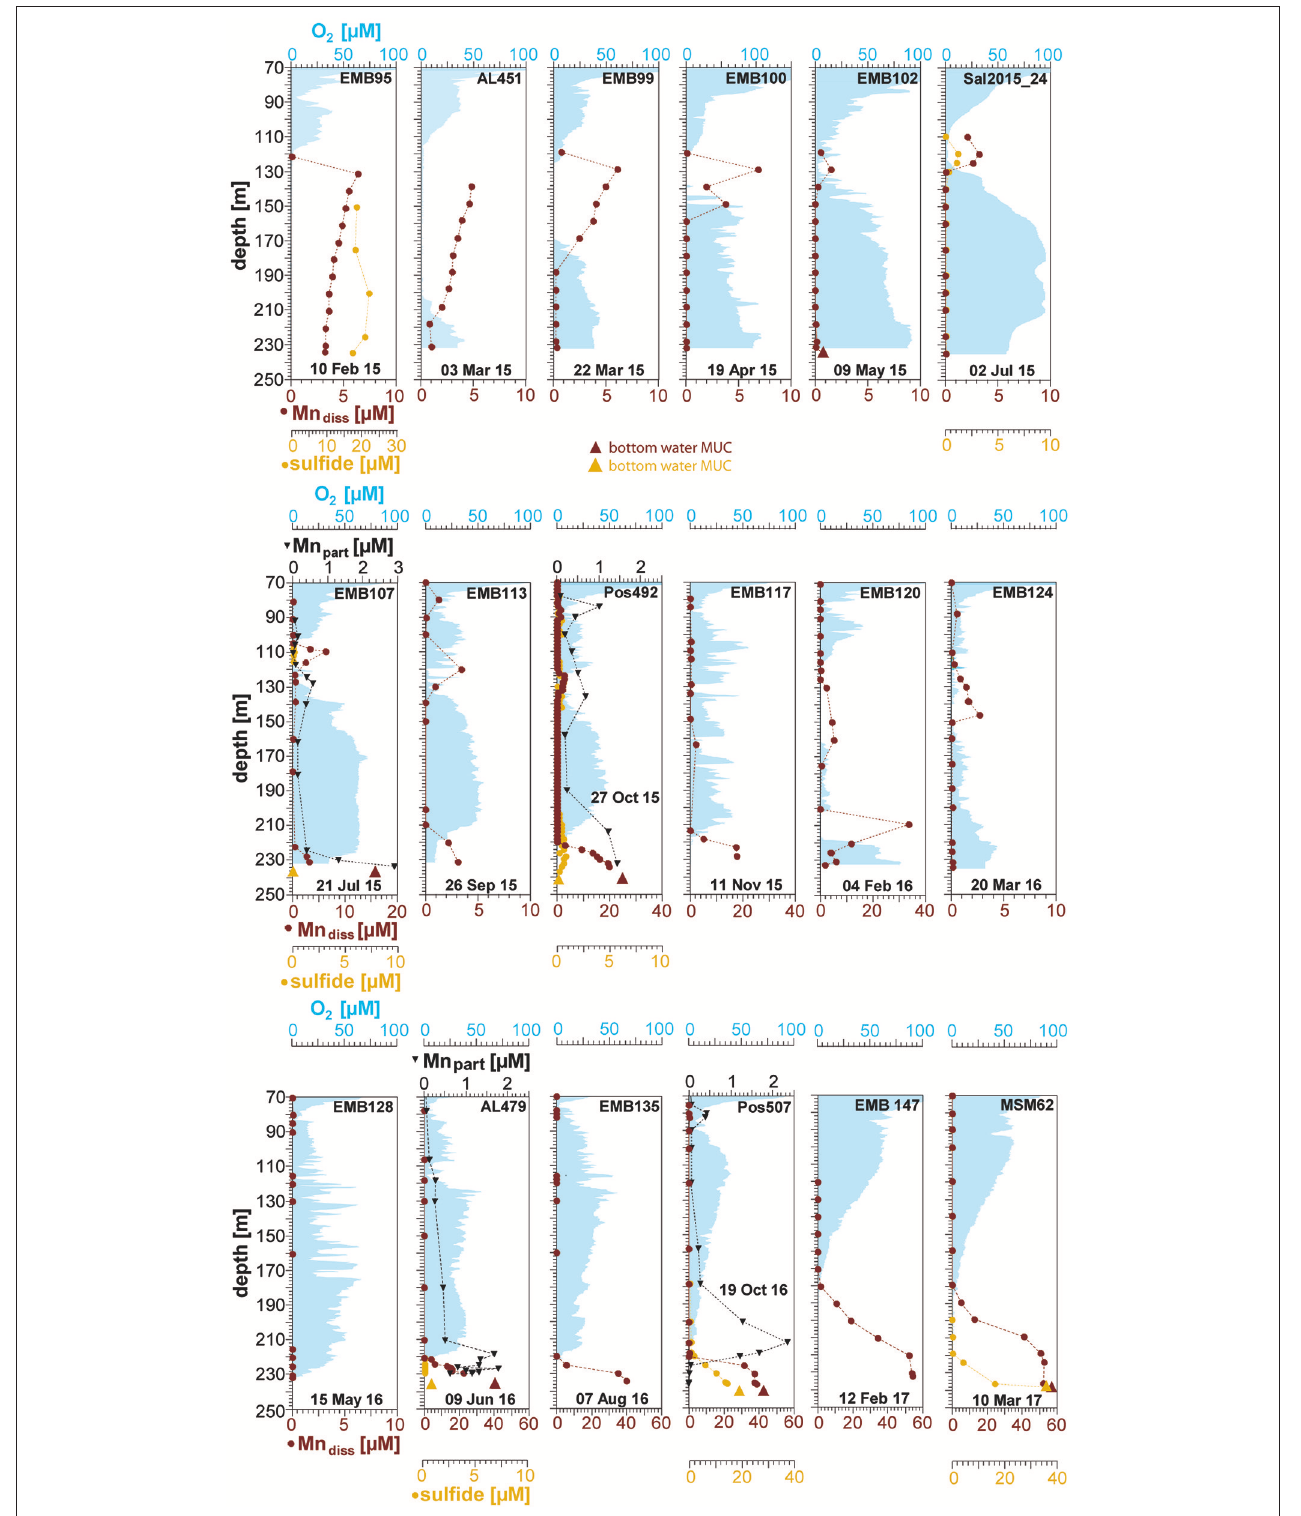
FIGURE 3 | Water column profiles of O 2 , dissolved and particulate Mn, and total sulfide as determined in samples obtained from station 271 in the central Gotland Basin between February 2015 and March 2017. Large yellow and brown triangles denote sulfide and Mn diss concentrations, respectively, in the supernatant water of the corresponding short